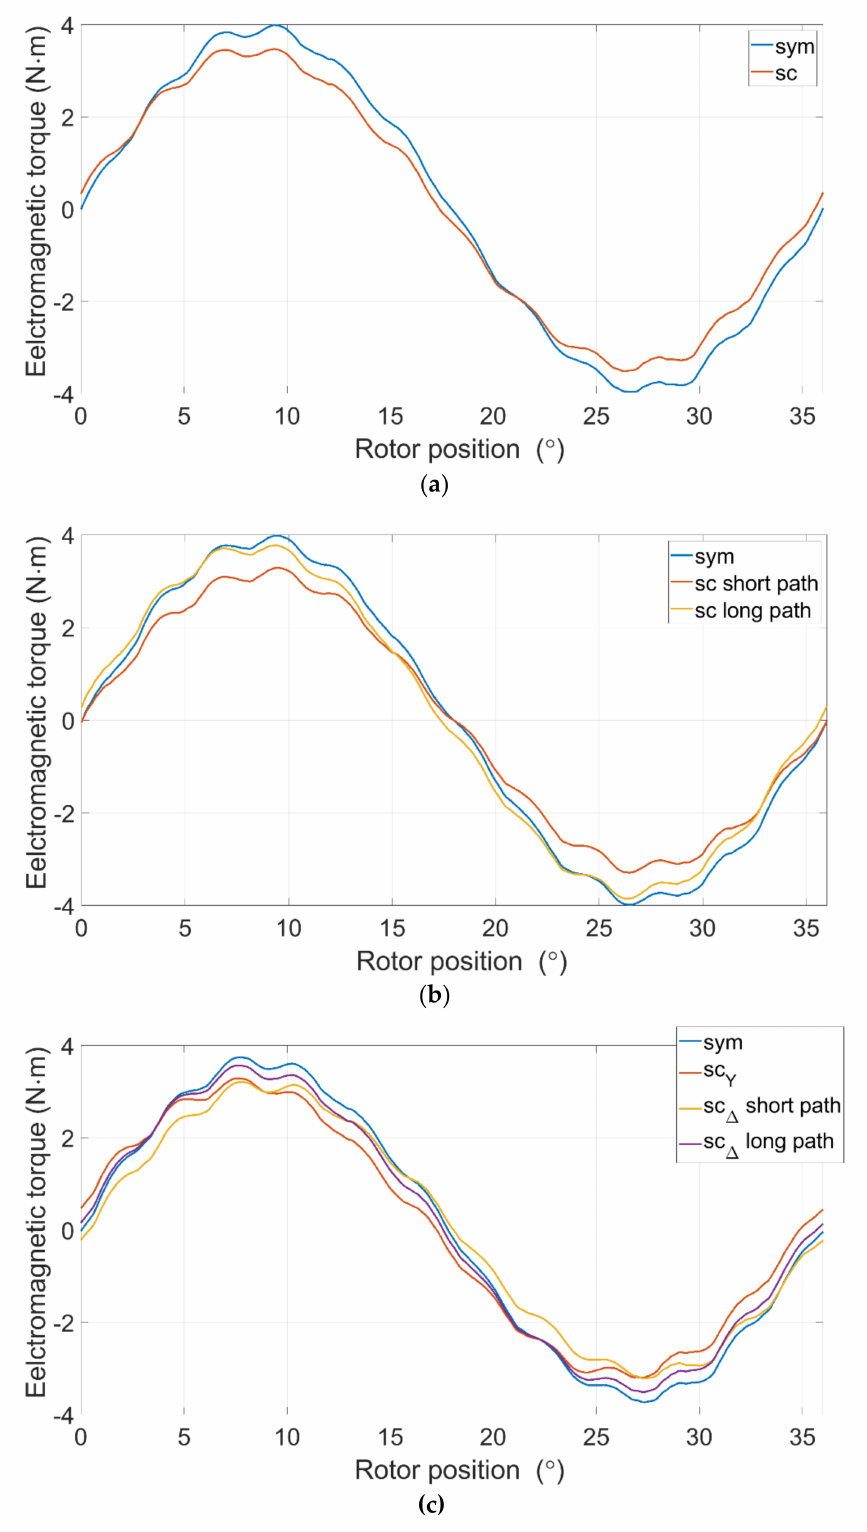
Figure 3. The static characteristics of the electromagnetic torque for the following